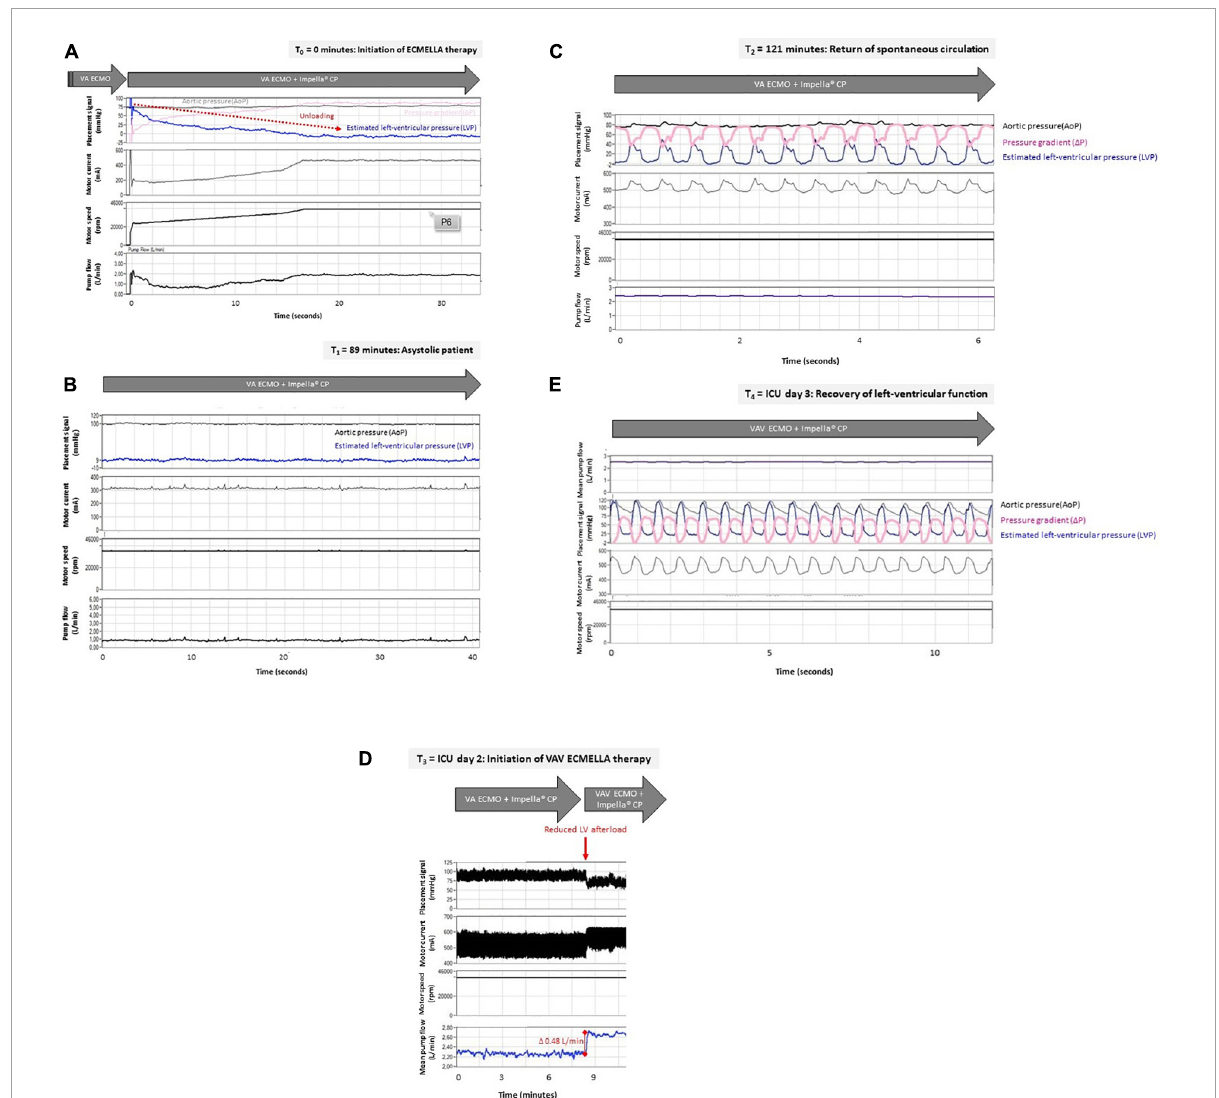
FIGURE3 (A–E) Left-ventricular unloading in a patient with out-of-hospital cardiac arrest treated with VAV ECMO and Impella R (cid:13) pump. Raw data were retrospectively retrieved from the Impella CP R (cid:13) console (Abiomed, Danvers, USA). For each given time point after initiation of ECMELLA therapy (T0) the estimated left-ventricular pressure (LVP in mmHg), aortic pressure (AoP in mmHg, derived from Impella R (cid:13) pressure sensor) or mean arterial pressure (MAP in mmHg), as well as Impella R (cid:13) motor current (milliampere, mA), Impella R (cid:13) motor speed (rotations per minute, rpm) and Impella R (cid:13) pump flow (liters per minute, L/min) are displayed. LVP was estimated based on AoP and pressure gradient ( (cid:49) P in mmHg, derived from Impella R (cid:13) motor current) as follows: LVP = AoP − (cid:49) P. (A) Impella CP R (cid:13) was inserted transfemorally in an asystolic patient with pre-existing VA ECMO. Displayed are the first 34 s after start of Impella CP R (cid:13) indicated by increasing motor current and motor speed. Depending on the Impella CP R (cid:13) flow (up to 2 L/min), the estimated LVP decreased to 9 mmHg (i.e., LV unloading indicated by red arrow). Therefore, despite asystole, the patient exhibited physiologic AoP (i.e., 75 mmHg) provided by VA ECMO flow of 4 L/min with sufficient unloading of the LV (physiologic LVP – LVEDP of 9 mmHg). (B) The patient remained in asystole without ROSC for approximately two hours after initiation of ECMELLA therapy indicated by static AoP and estimated LVP (no pulsatility). In this case, an Impella R (cid:13) pump flow of 1 L/min was sufficient to unload the LV (estimated LVP, i.e., LVEDP under asystole of 9mmHg) while a VA ECMO flow of 4 L/min provided a sufficient hemodynamic support (i.e., MAP 100 mmHg). (C) ROSC with sinus rhythm was achieved after approximately two hours following initiation of ECMELLA therapy as being indicated by undulating estimated LVP (pulsatility indicating cardiac contractions). Flat AoP (greater than estimated LVP) indicates lack of aortic valve opening. Of note, Impella R (cid:13) pump flow was set to 2.5 L/min which reduced LV preload. VA ECMO flow was set to 4 L/min. (D) Two days after ICU admission, VA ECMO therapy was advanced to VAV ECMO therapy while the Impella R (cid:13) pump remained inserted. Induction of VAV ECMO therapy (i.e., reduction of ECMO outflow to the aorta and therefore reduction in LV afterload) was associated with increased mean Impella R (cid:13) pump flow (increase in Impella R (cid:13) pump flow of 0,48 L/min, indicated by red line) with given constant pump settings (Impella R (cid:13) motor current). Impella pump flow was 2.7 L/min, VA ECMO flow was 2.5 L/min and VAV ECMO flow was 1.5 L/min. (E) Differential hypoxemia was successfully reversed by VAV-ECMELLA. LV function fully recovered over the next days. Estimated LVP was now greater than AoP resulting